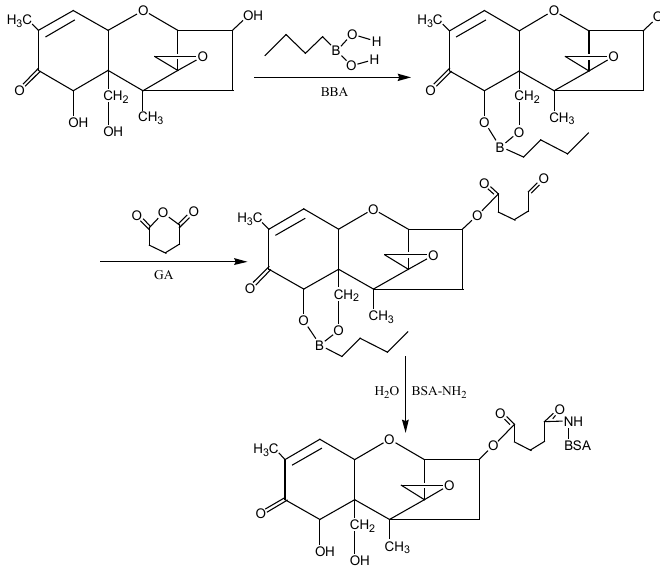
Figure 10. The synthesis route of DON - BSA by the NHS method.